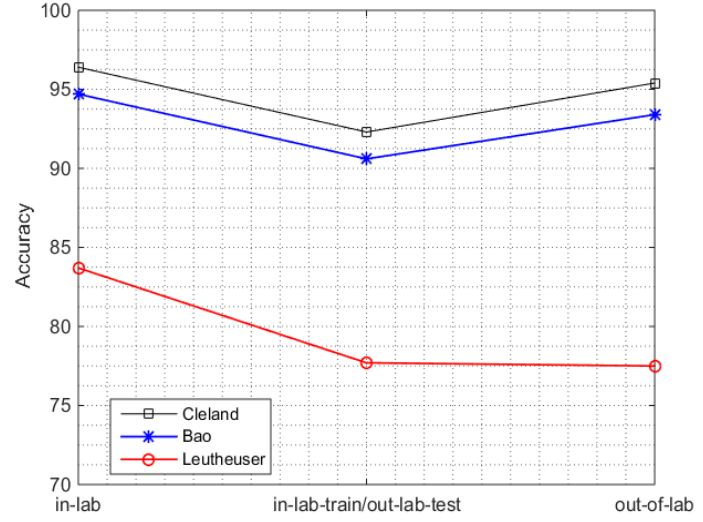
Figure 3. Performance analysis of in-lab, out-of-lab, and in-lab training/out-lab testing scenario for all PAC system using sensor set S OUT (Table 4).